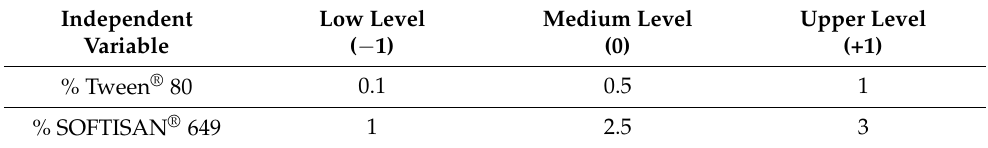
Table 1. Upper, middle, and lower levels for each independent factor of the experimental